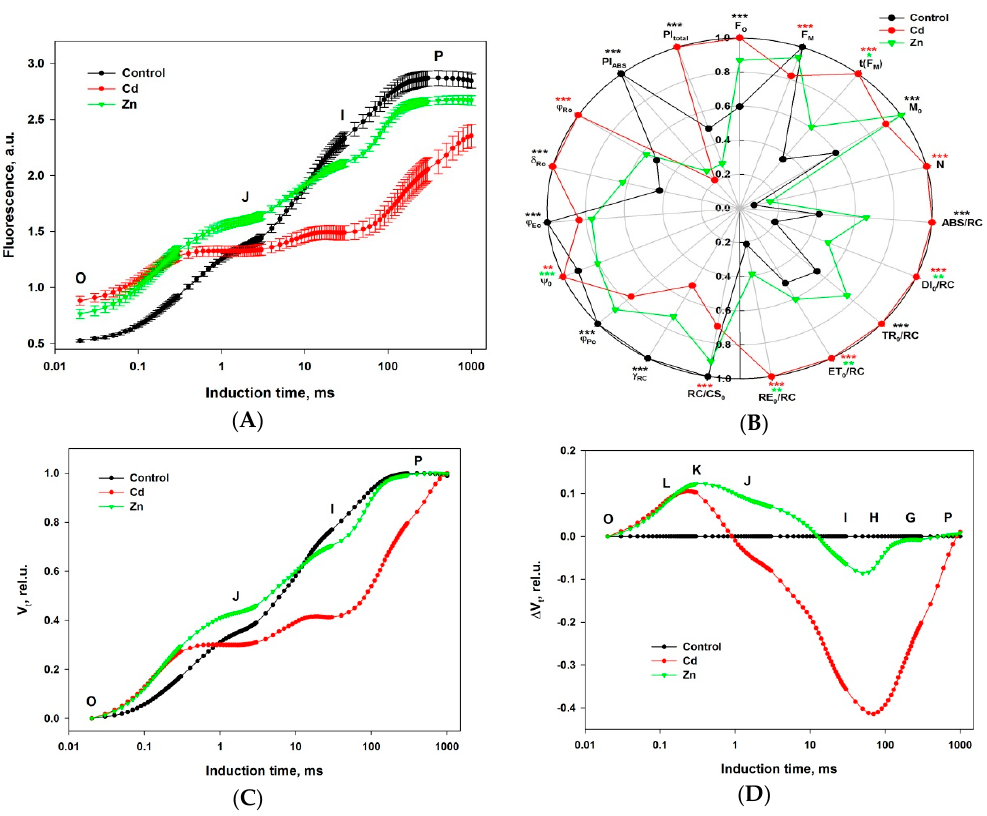
Figure 1. ( A ) Induction transients of chlorophyll a fluorescence in leaves of wheat ( Triticum durum Desf. (cv. Beloslava)) plants—control (black), exposed to 50 µM Cd (red) and 600 µM Zn (green). The whole plants were adapted to dark in room for 1 h and additionally the measured spots were kept in dark in the clip for 1 min just before measurement. Induction curves of ChlF were recorded for 1 s with 3000 µmol m − 2 s − 1 PPFD. Each point in the graph is an averaged value of 6 repetitions and the standard errors are shown. The characteristic levels (O, J, I, and P) of the induction transients are denoted with letters. ( B ) Parameters of the JIP test (described in Table 1) are calculated from the curves shown in A. The asterisks above each parameter indicate if there is statistical significance for the Cd (red) or Zn exposure (green) or for both treatments (black): 1 asterisk— p < 0.05, 2— p ≤ 0.01, and 3— p ≤ 0.001. ( C ) Induction curves of the relative variable chlorophyll fluorescence (V t ) resulting from double normalization of the values in ( A ) to the minimal (F O ) and maximal (F M ) levels. The characteristic levels (O, J, I, and P) of the induction curves are denoted as in ( A ). ( D ) Curves of differential values ( Δ V t ) resulting from subtracting the control from exposed V t . The times of the induction curves characteristic levels (O, J, I, and P) are marked as well as the intermediary levels (L, K, H, and G) at which Δ V t peaks and shoulders occur.